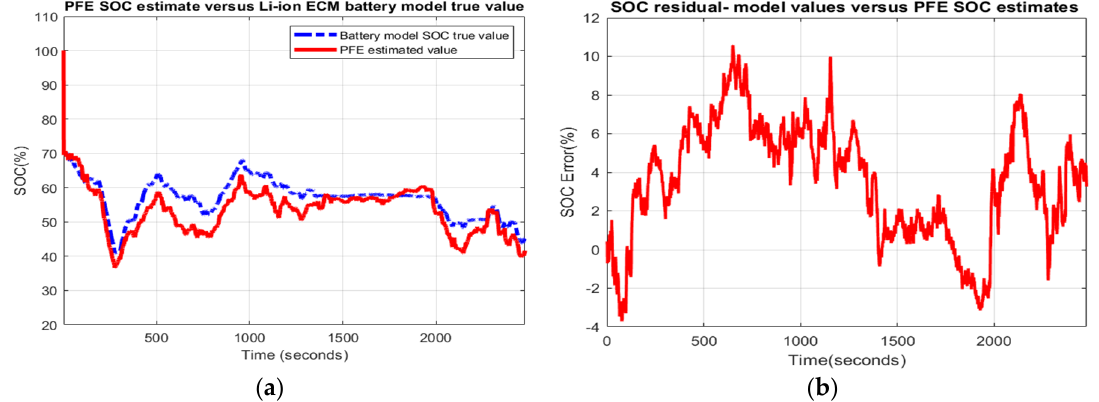
Figure 10. Robustness to simultaneous changes, SOCini = 1, Qnom = 4.2 Ah (ageing effects); ( a ) PFE SOC value versus 3RC ECM battery model true value; ( b ) SOC residual. Batteries 2020 , 6 , x FOR PEER REVIEW